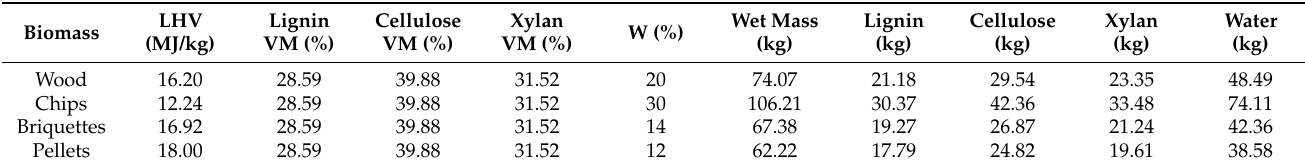
Table 6. Parameters obtained for the different biomass to produce 1000 MJ.